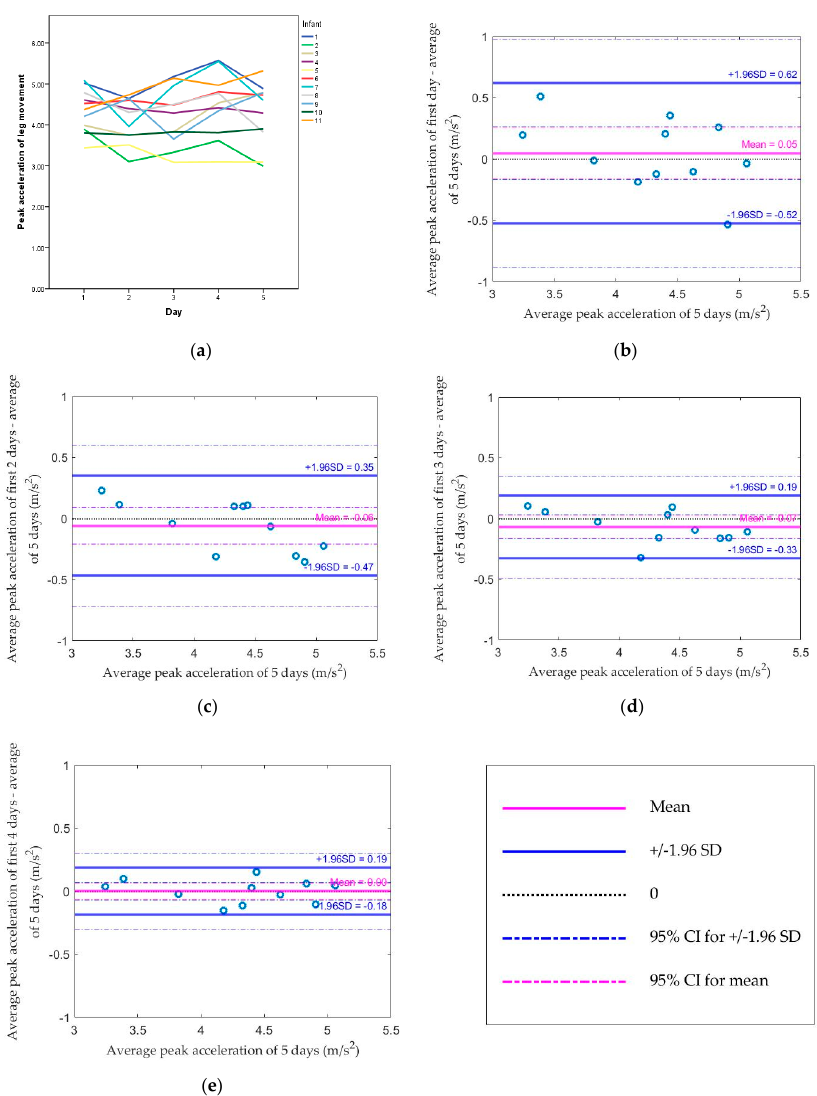
Figure 4. ( a ) Peak acceleration of leg movement from the first day to the fifth day for each infant; Bland–Altman plots comparing ( b ) the first day, ( c ) the average of the first 2 days, ( d ) the average of the first 3 days, ( e ) the average of the first 4 days, and the average of 5 days for the peak acceleration of leg movement.